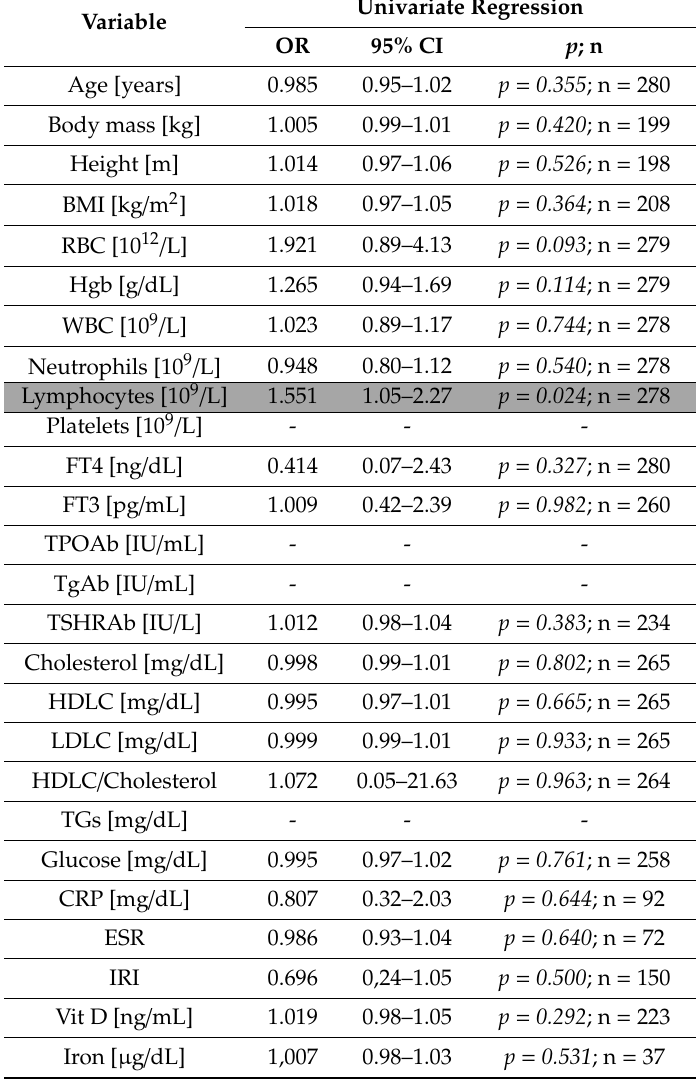
Table 3. Univariate logistic regression analysis of the univariate increased TSH (for TSH ≥ 2.5 mIU / L) determinants (variables), performed in women of childbearing age with normal thyroid tests (n = 280). OR, odds ratio; CI, confidence interval; Statistical significance was determined at the level of p < 0.05. Statistically significant di ff erences are shaded. The level of statistical significance is given in italics.